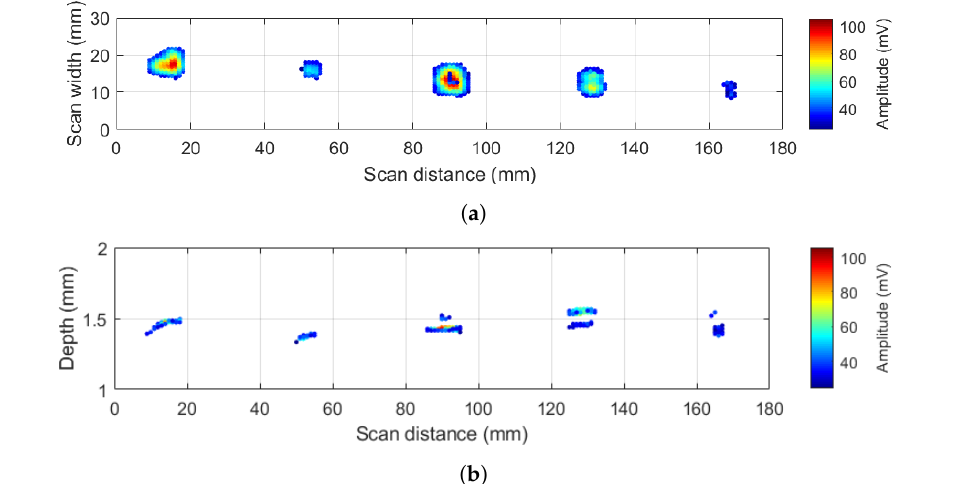
Figure 13. ( a ) sizing, and ( b ) depth information of 6x6 mm inserts in the calibration